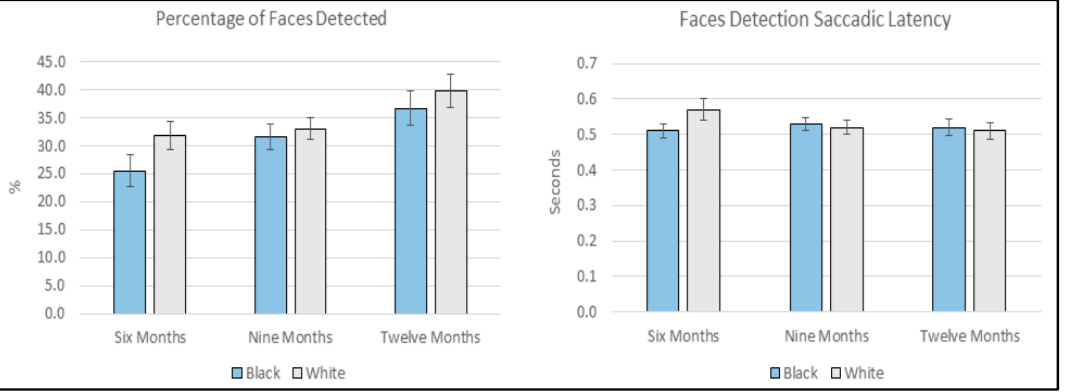
Figure 3. The percentage of total faces (8 per race condition) that were detected and saccadic latency for face detection (seconds) for own- and other-race faces divided by age. Error bars are standard error of the mean.